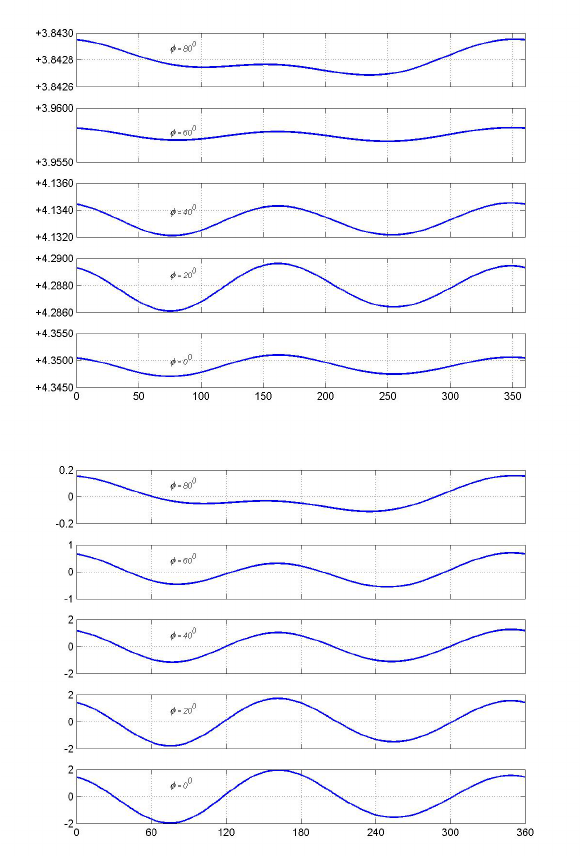
Figure 6: The vertical axes show (top) the radius r ( φ ) in km + 42160 km and (bottom) the change of the radius dr = r − ¯ r ( φ ) in m along parallel circles of a geosynchronous satellite. The horizon- tal axis shows the longitude in